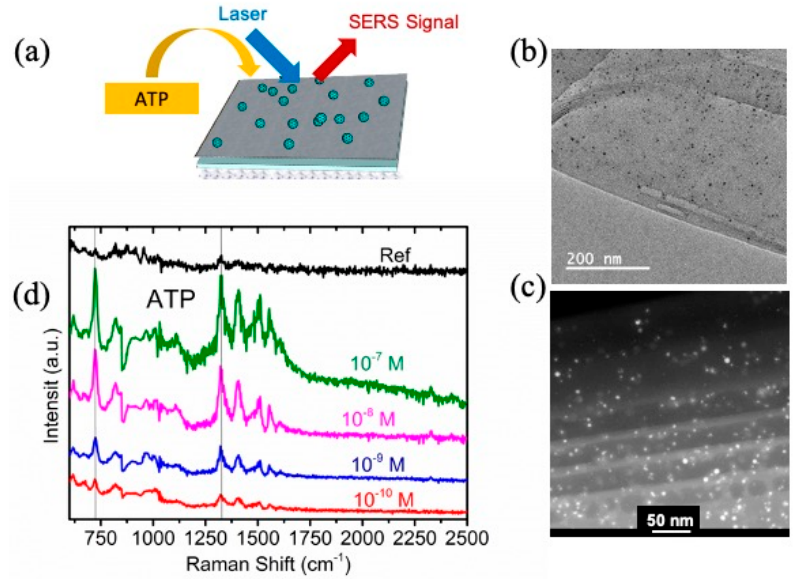
Figure 8. ( a ) Experimental setup for the evaluation of SERS-based biosensing performance using supported carbon NSHs-NPs. ( b ) TEM and ( c ) STEM images of carbon NSHs-NPs after exfoliation process, showing the distribution of Fe@Ag@Si NPs on the surface of carbon NSHs. ( d ) Concentration-dependent SERS of ATP deposited on supported NSHs-NPs. The “Ref” spectrum corresponds to 10 − 2 M ATP, which was dispersed directly on a Cu substrate. Reprinted with permission from Ref. [24]. Copyright 2016, American Chemical Society.